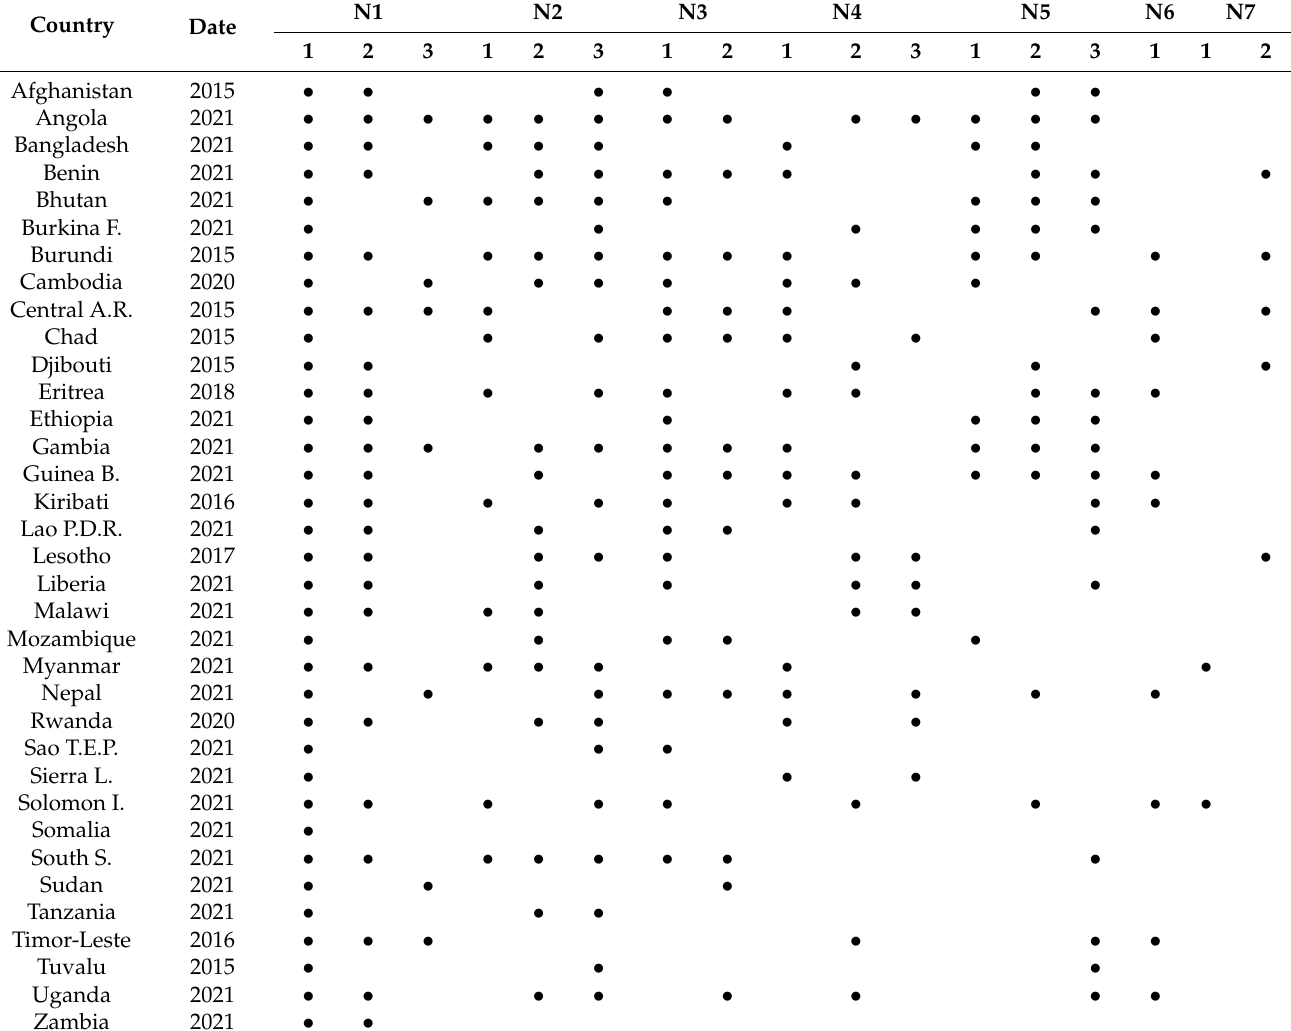
Table 1. Need (N) factors communicated in the NDCs.